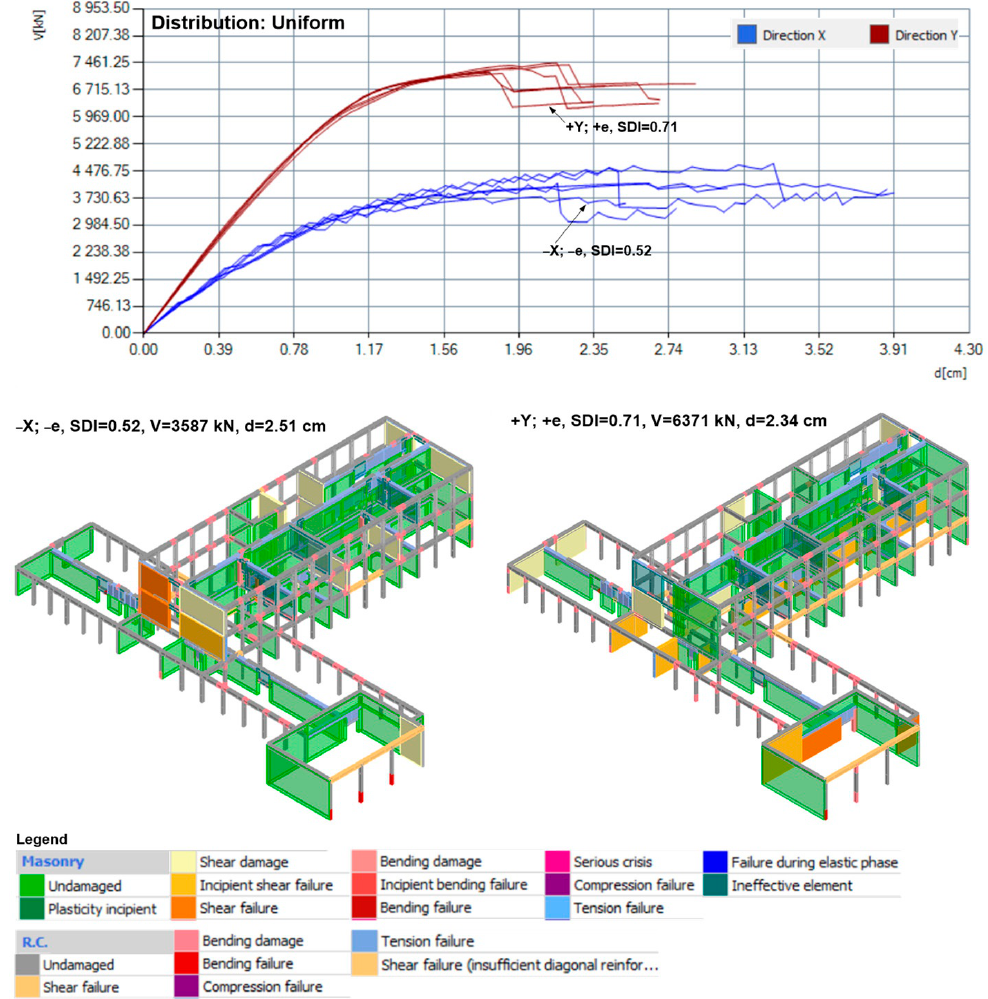
Figure 20. EFM results: pushover curves and corresponding damage mechanism of the building obtained using the uniform load pa tt ern.